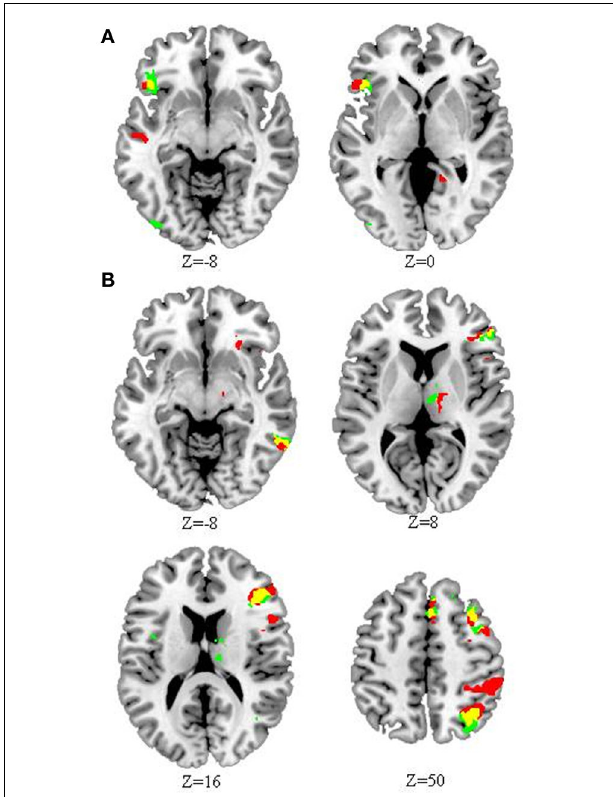
FIGURE 2 | Differential activation in congenitally deaf (CD) compared to hearing control individuals (HC) within the rhyming and meaning tasks. (A) Reduced activation in CD compared to HC in the rhyming (red) and meaning (green) tasks. (B) Greater activation in CD compared to HC in the rhyming (red) and meaning (green) tasks. For both (A) and (B) , yellow indicates overlap. Compared to HC, CD showed reduced activation in left inferior frontal cortex, but greater activation in right inferior frontal, inferior parietal, and inferior temporal cortex, among other regions, for both tasks. The threshold for the whole brain comparisons was set at p < 0 . 05 AlphaSim corrected ( p < 0 . 005 voxel-level cut-off). The number below each map (Z) represents axial coordinates in MNI